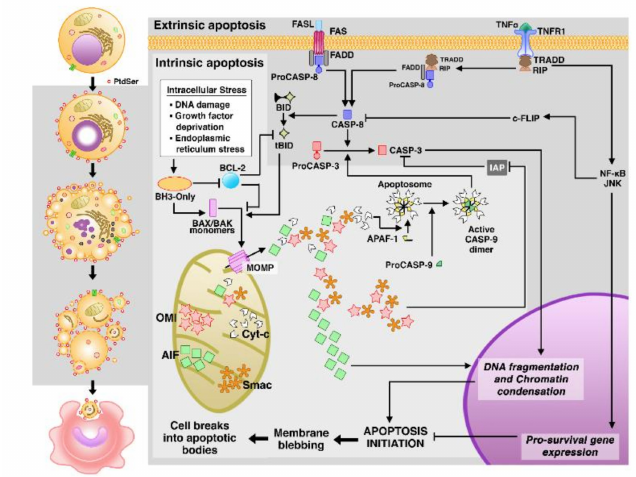
Figure 1. Morphological and molecular representation of apoptosis. On the left side of the figure (white background), apoptosis is morphologically characterized by alterations frequently observed such as cell shrinkage, nuclear fragmentation, membrane blebbing, and the formation of apoptotic bodies in vitro. In vivo apoptotic cells usually expose phosphatidylserines (PtdSer) in their outer membrane which function as a signal for efferocytosis by phagocytes cells. On the right, the general scheme of extrinsic and intrinsic apoptosis pathways. In the extrinsic pathway, death receptors are activated by external stimuli and, in the intrinsic pathway, mitochondrial stress stimuli occur. AIF: apoptosis-inducing factor; cFLIP: cellular FLICE inhibitory protein; Smac: Second mitochondria- derived activator of caspase; OMI/HTRA2: High-temperature requirement A2; JNK: Jun N-terminal